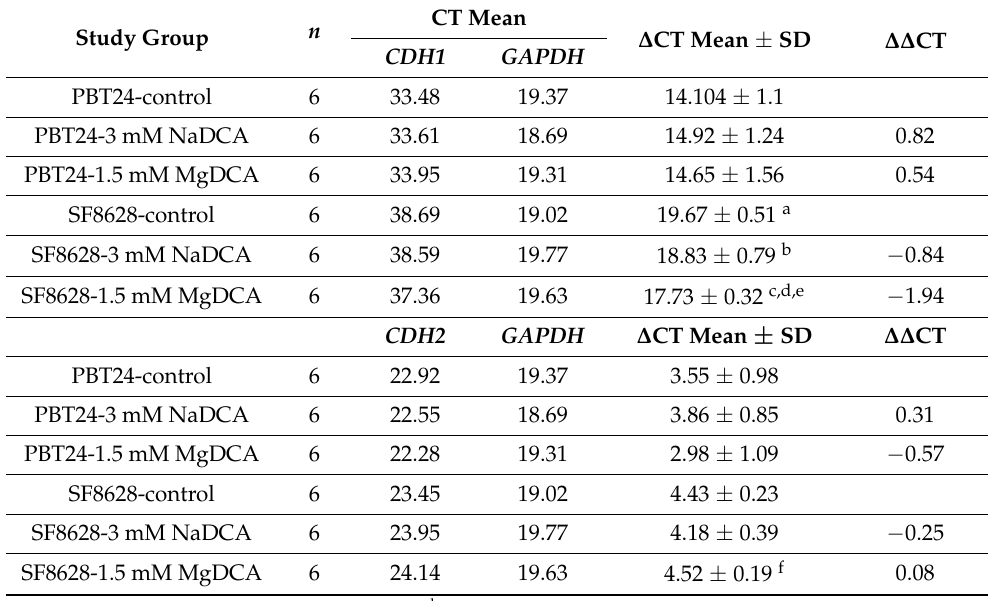
Table 7. The CDH1, CDH2 , and GAPDH expression in the studied PBT24 and SF8628 cell groups. CT Mean Study Group n